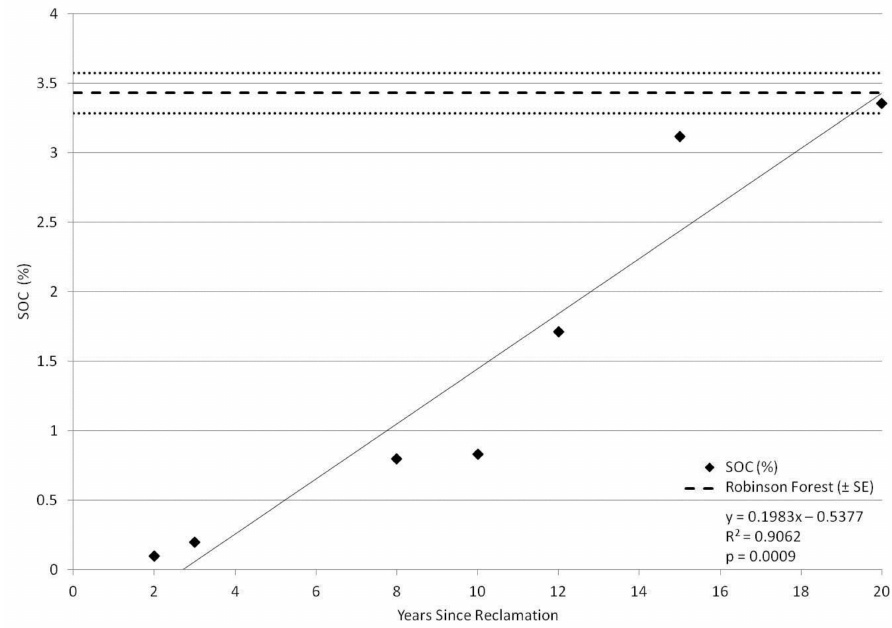
Figure 3. Changes in soil organic carbon (SOC; LECO analysis) in mine soils over time since reclamation, with mean % SOC ( ± SE) for Robinson Forest plotted for